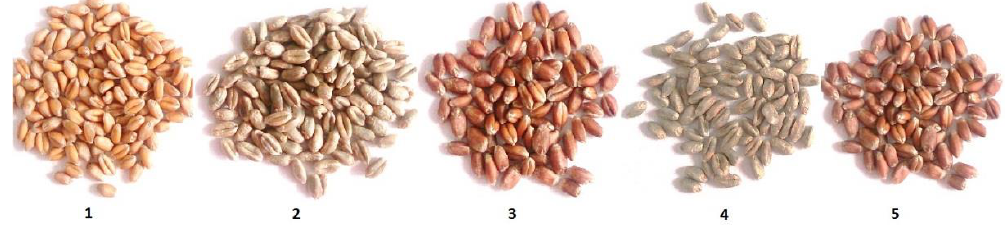
Figure 6. Coloured wheat seeds of the genotypes used in experiments 1—Citrus yellow, 2—KM 53-14 Blue, 3—KM 178-14 purple, 4—Skorpion Blue aleurone, 5—PS Karkulka purple. Coloured grains have blue aleurone (Ba genes), purple pericarp (Pp genes) and yellow endosperm (Psy genes), which are determined by the presence of anthocyanins and carotenoids [59]. The blue aleurone (Ba genes) pericarp got grains of KM 53-14 Blue and Skorpion Blue aleurone wheat genotype. The purple pericarp (Pp genes) got grains of KM 178-14 purple and PS Karkulka purple wheat genotype. The yellow endosperm (Psy genes) have grains of Citrus yellow wheat genotype.